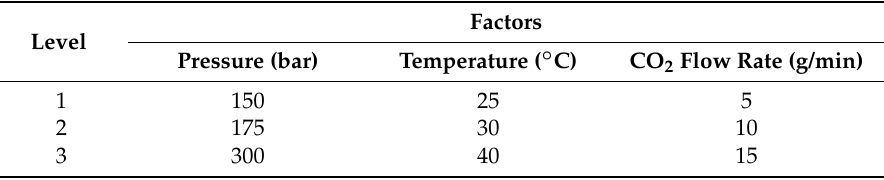
Table 1. Parameters and levels used in the experimental